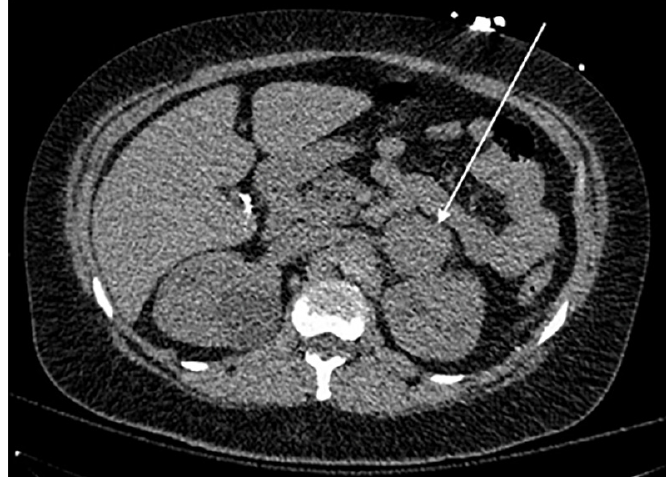
Image 3. Computed tomography showing soft tissue density le - sion measuring approximately 4 centimeters (cm) x 4.5 cm in the left suprarenal